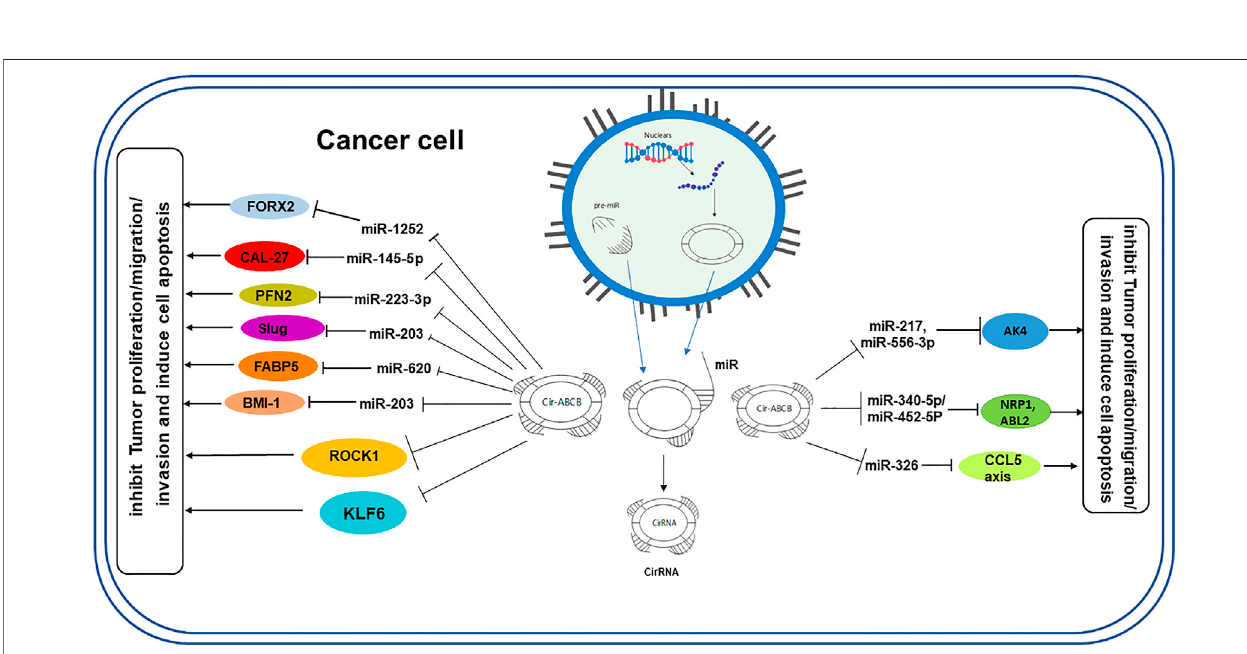
FIGURE 2 | Overview of circ-ABCB10 function as a miRNA sponge in the proliferation and metastasis of various cancer cell types. Circ-ABCB10 is released from the nucleus, acting as a sponge of miRNAs that regulate target genes to promote or inhibit tumor growth.